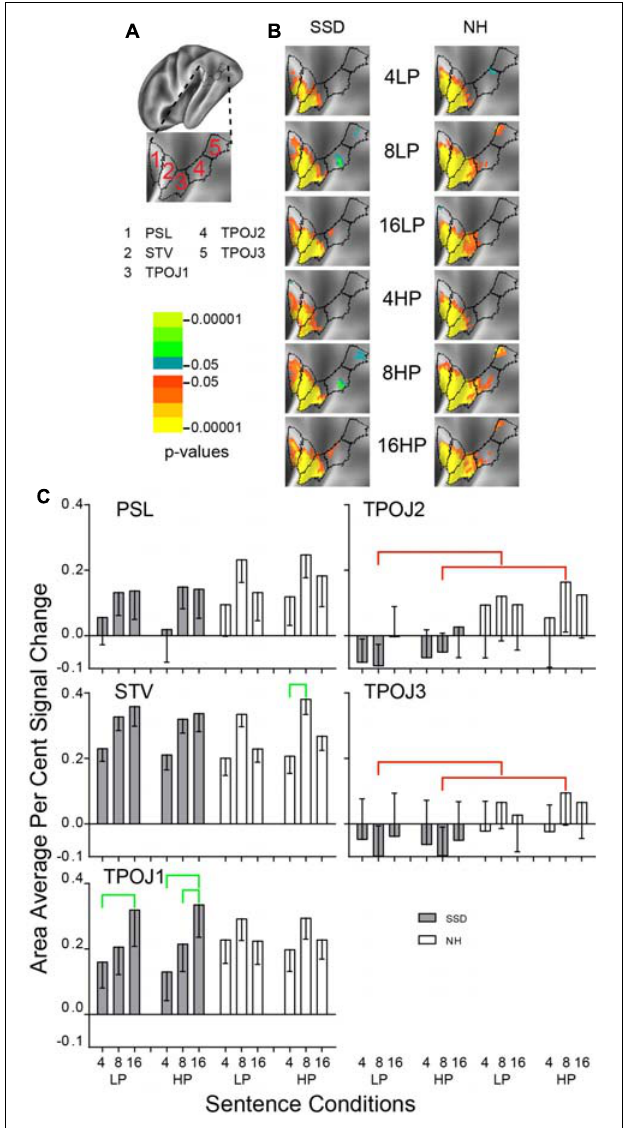
FIGURE 10 | Results from five parcels in the LH Temporal-Parietal-Occipital Junction (TPOJ) region. (A) Lateral view of a partially inflated hemisphere rotated superior 45 ◦ to align the parcels. (B) Enlarged views of parcels show clusters with significant mean z-scores of p < 0.05 for positive BOLD (colored red-orange to bright yellow) and negative BOLD scaled blue to light green. (C) TPO2 and TPO3 had significant group effects marked with red brackets. STV and TPOJ1 had significant intelligibility effects marked with green brackets.